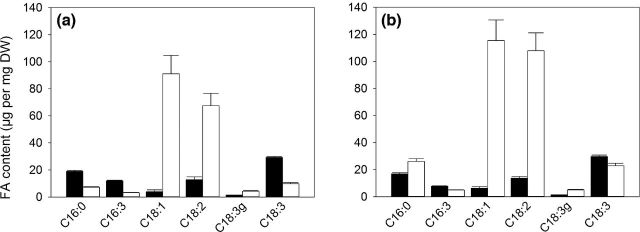
Absolute quantification of fatty acid content in Zygnema sp. B (a) and Zygnema sp. C (b). Black bars show young cultures and white bars mature cultures. The FAs shown here were quantified using external standards; relative quantification data is also available for all other detected compounds (Fig. S2, Supporting Information). Data are means plus standard deviation (n = 5). Welch's two sample t-test with Bonferroni correction proved that the content of each fatty acid (within strain) was significantly different between young and mature cultures (P < 0.001).